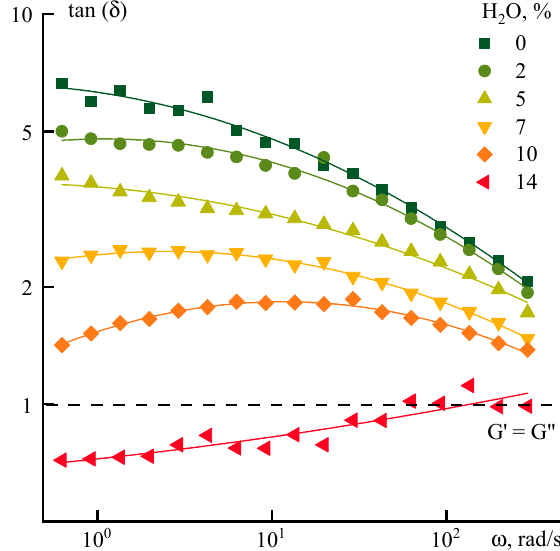
Figure 10. Dependence of the tan( δ ) for PANI-O solutions with water addition on